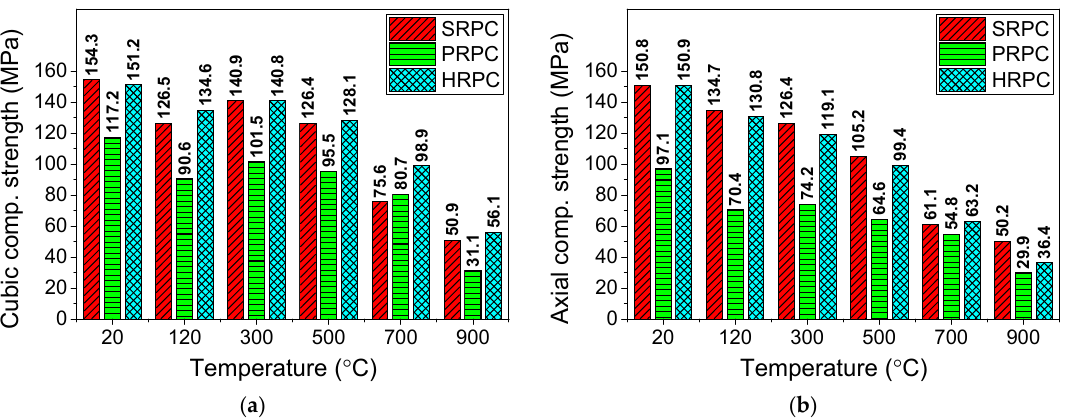
Figure 4. Compressive strength of RPC for ( a ) cubic and ( b ) prismatic specimens.